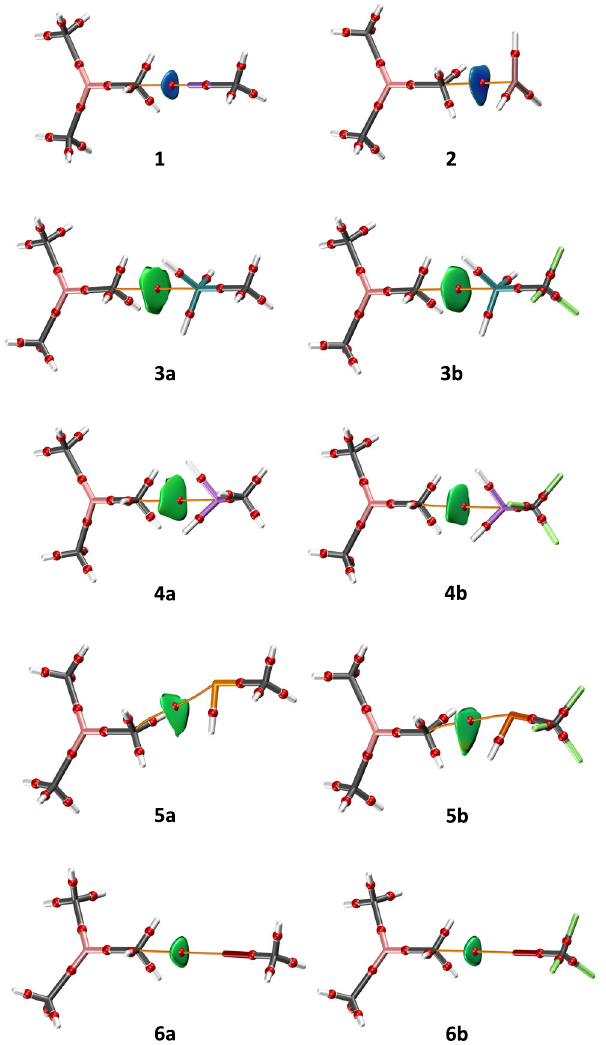
Fig. 8 Model systems. NCI graphs of the optimized adducts 1 , 2 , 3a – 6a , 3b – 6b formed by Al(CH 3 ) 3 and several Lewis acids.